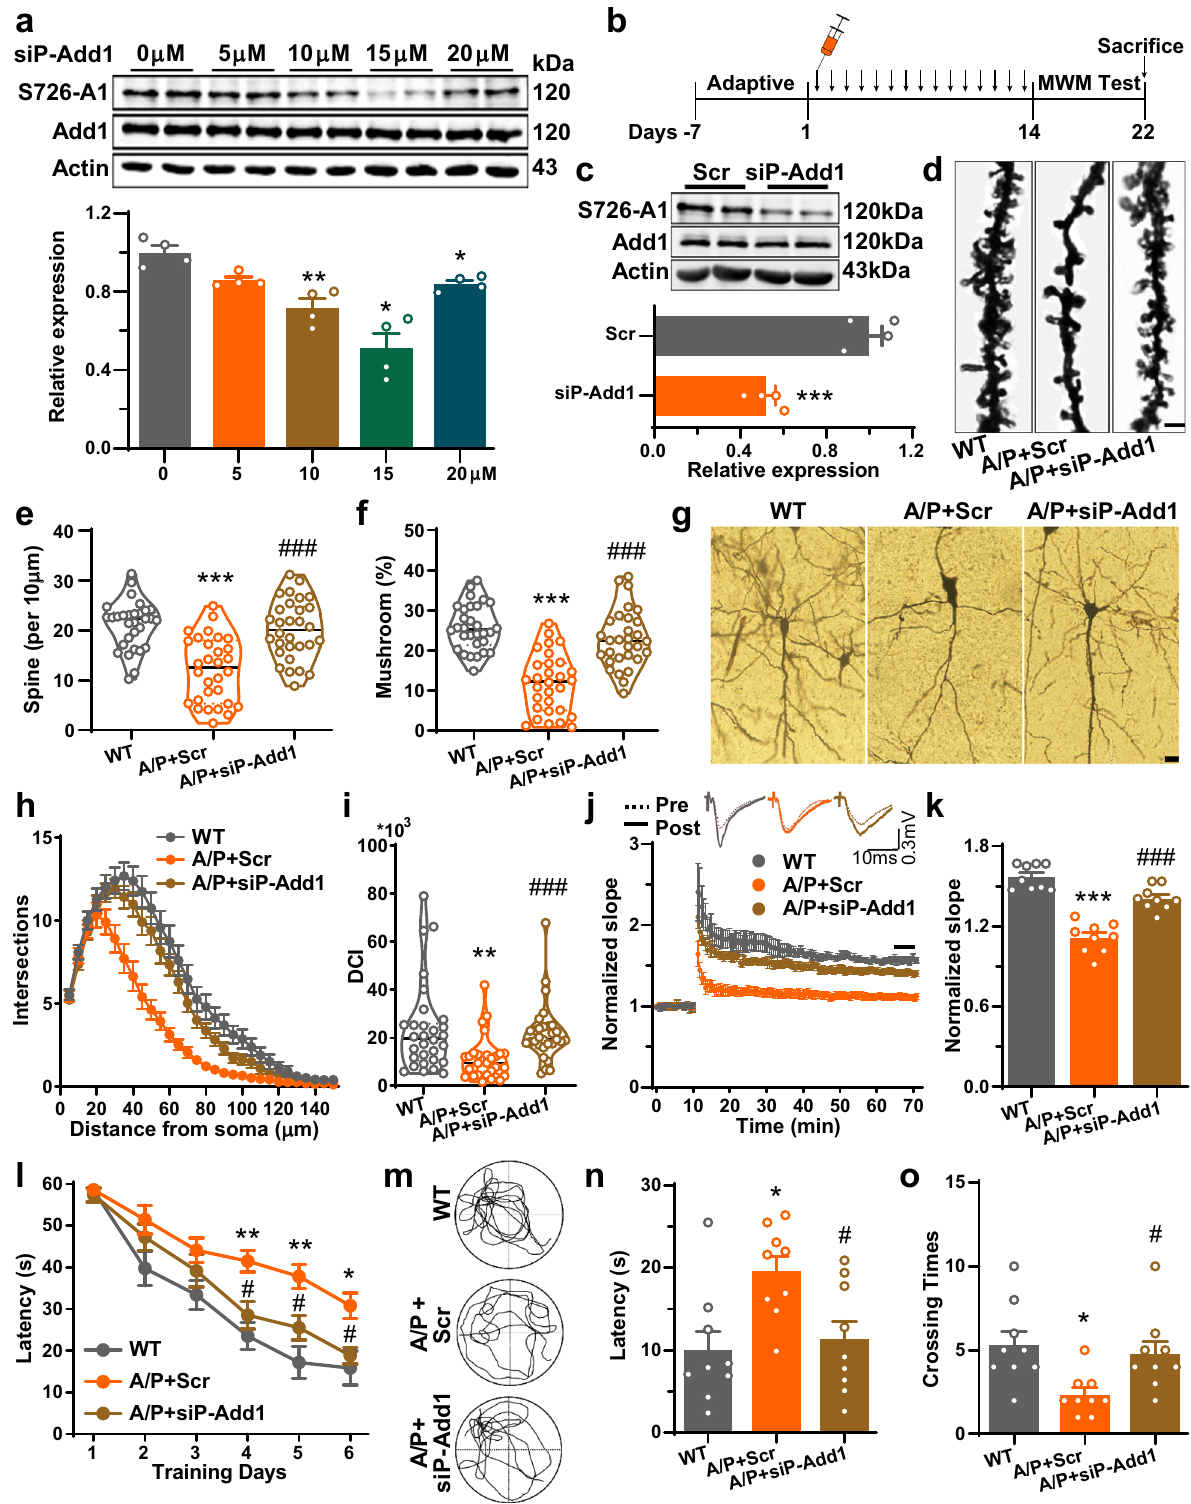
movements of mice were recorded by a video camera connected to a computer. There was no task on the seventh day and mice got a rest. On the eighth day, the hidden platform was removed, mice were tested to fi nd the platform from the opposite quadrant for 60s (probe trial). The latency to reach the place of the platform, the percent time spent in the target quadrant, the crossing times to the platform regions, and the swimming velocity was